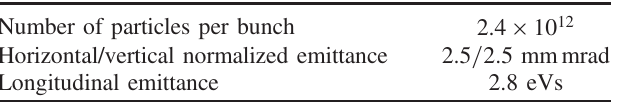
TABLE III. Ultimate LHC 25 ns beam parameters used for simulations. The longitudinal emittance is rescaled as a para- bolic squared distribution is assumed instead of a parabolic distribution.